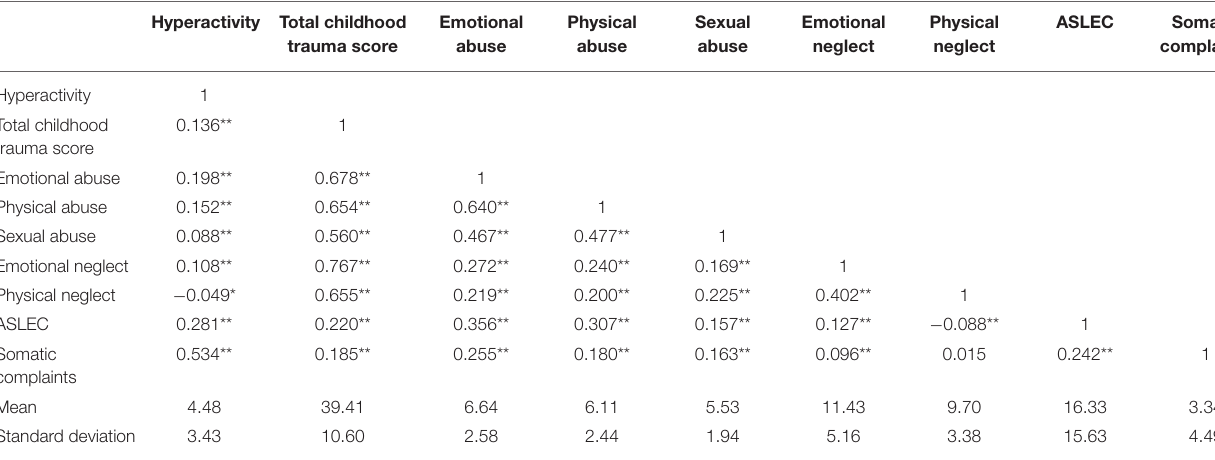
TABLE 2 | Correlations among scores for hyperactivity, childhood trauma, ASLEC, and somatic complaints ( n = 1,586). Hyperactivity Total childhood trauma